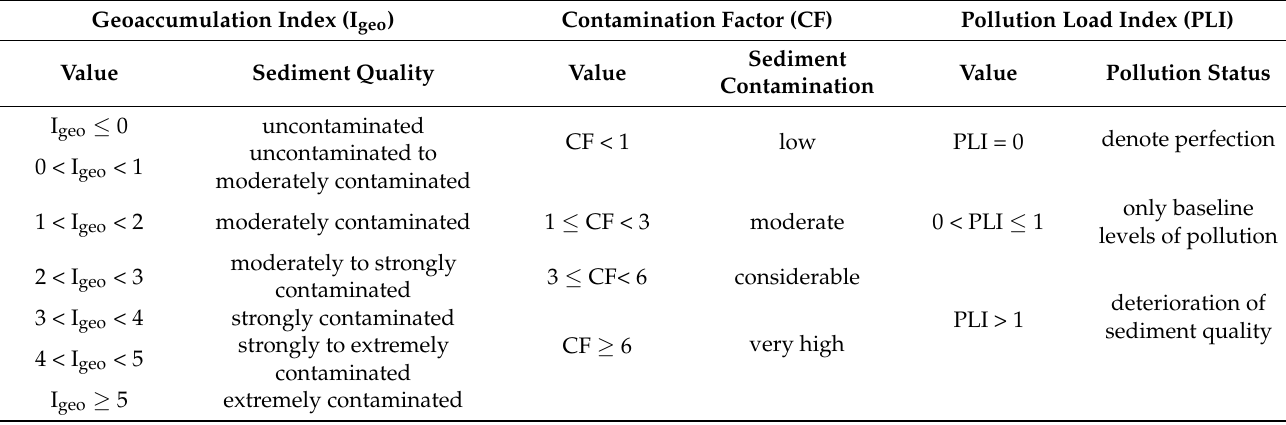
Table 1. Interpretation of values and classes of used